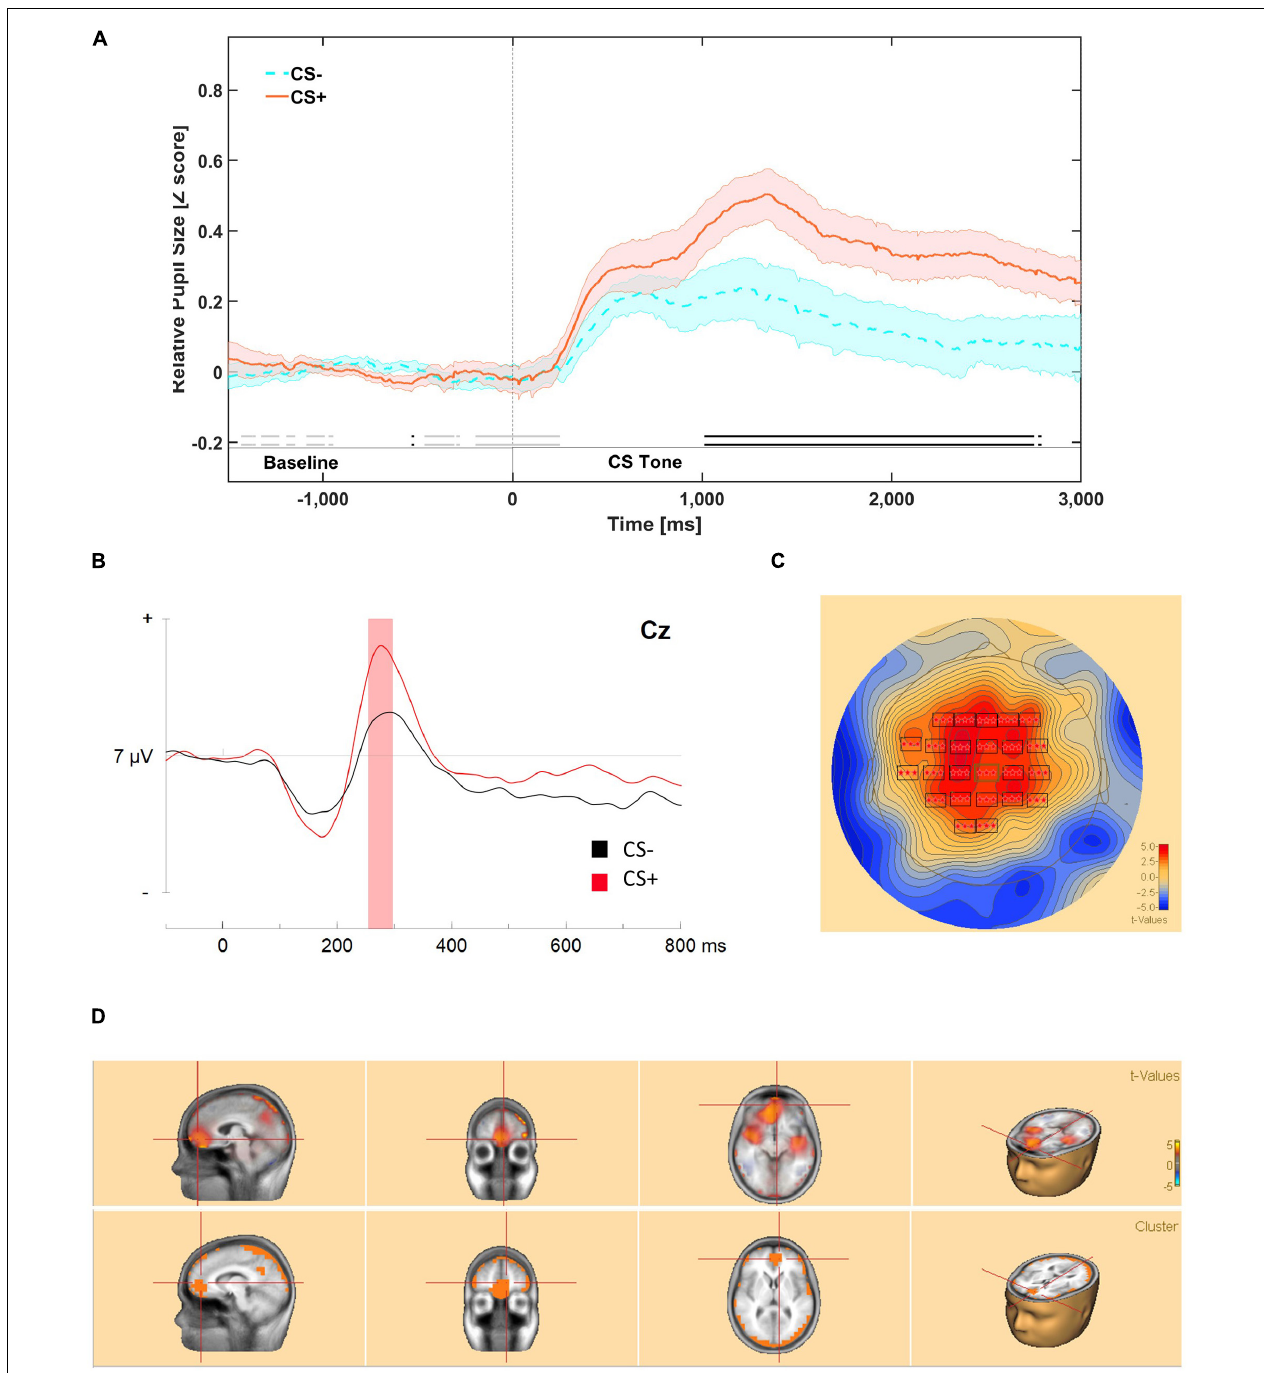
FIGURE 2 | (A) Mean relative pupil dilation ( z -score) responses during first order tones in phase 3, between –1500 ms (pre-stimulus onset) and 3000 ms (post-stimulus onset). Meaningful differences (BF 10 ≥ 3) are indicated by an opaque double line along the X axis of the figure, above the segment labels. Evidence in favor of the null hypothesis is indicated by faded double line near the bottom of the figure. The dark line in color represents the mean of that condition (orange for CS+/US+ trials and blue for CS–/US– trials). The lighter color bands surrounding the darker colored lines represent Standard Error of the Mean. (B) ERP response to first-order stimuli presented during phase 3: higher-order conditioning at Cz. Bootstrap cluster analyses revealed a significant difference from 240 to 300 ms. (C) Mean potential distribution maps average across participants ( n = 14 at scalp level. The significant positive modulation peaks bilaterally in frontal-parietal areas. (D) Source estimation analysis was conducted from 245 to 300 ms encompassing the significant greater modulation identified in source estimation. A positive significant source was identified right medial prefrontal cortex.